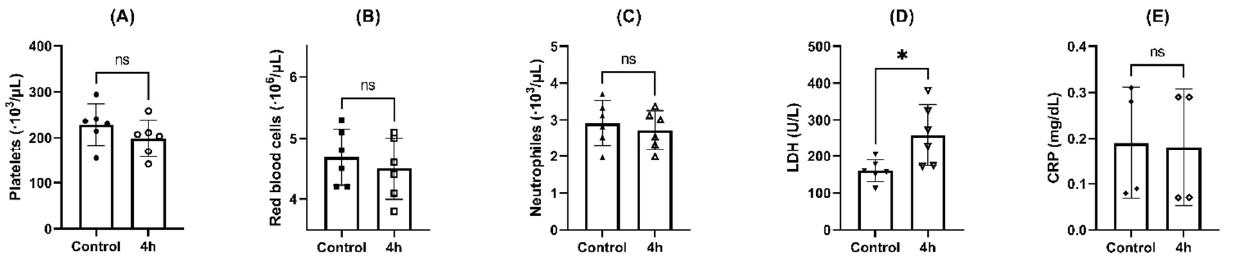
Figure 6. Effects of NPs on hematological parameters after incubation for 4 h at 37 °C: ( A ) platelets; ( B ) red blood cells; ( C ) neutrophils; ( D ) LDH; and ( E ) CRP. Paired t-test: ns = p > 0.05; *= p < 0.05, (n = 6).